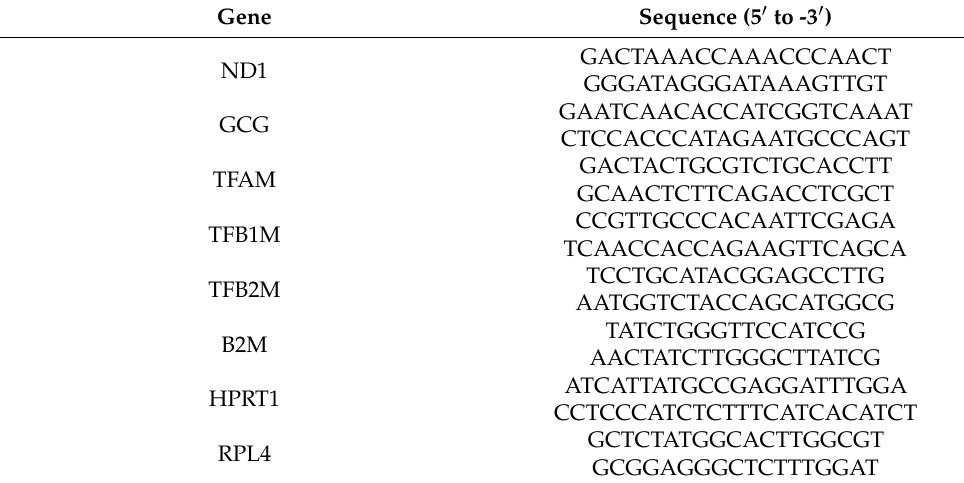
Table 1. Primers used for real-time-PCR-specific amplification.